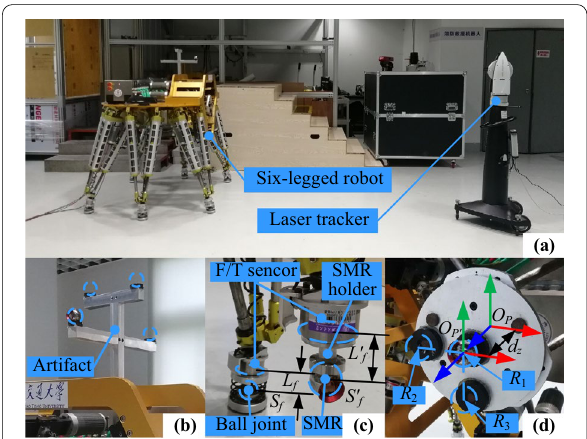
Figure 5 Experimental setup: a Overall setup, b reference artifact on the body, c SMR holder under the foot, d calibration artifact on the moving